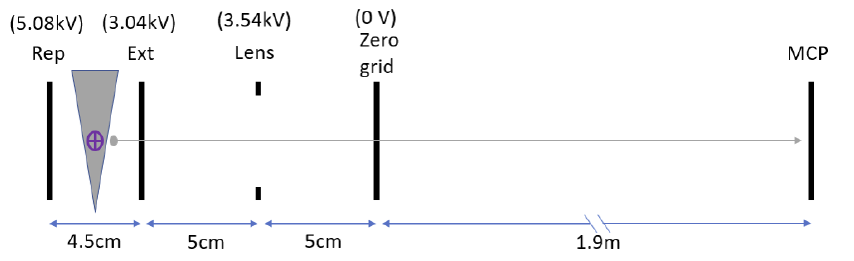
Figure 3. A schematic representation of the ion-optics inside the TOF-MS. The four electrodes indicated are: a repeller plate (Rep), an extraction grid (Ext), an electrostatic lens and a zero-voltage grid. The grey triangle (not to scale) represents an upward-expanding conical plume of silver and the purple cross-mark indicates the excitation lasers incidence orthogonal to the vertical axis of the plume. The grey dot represents a laser-ionized silver ion which is guided to the MCP with the ion-optics